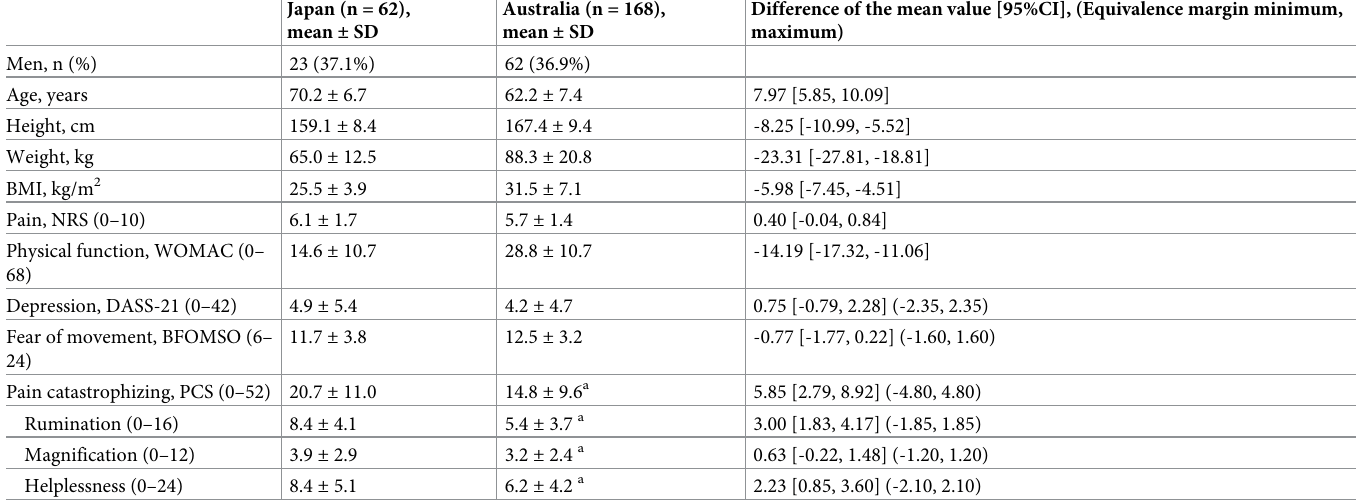
Table 1. Descriptive characteristics and